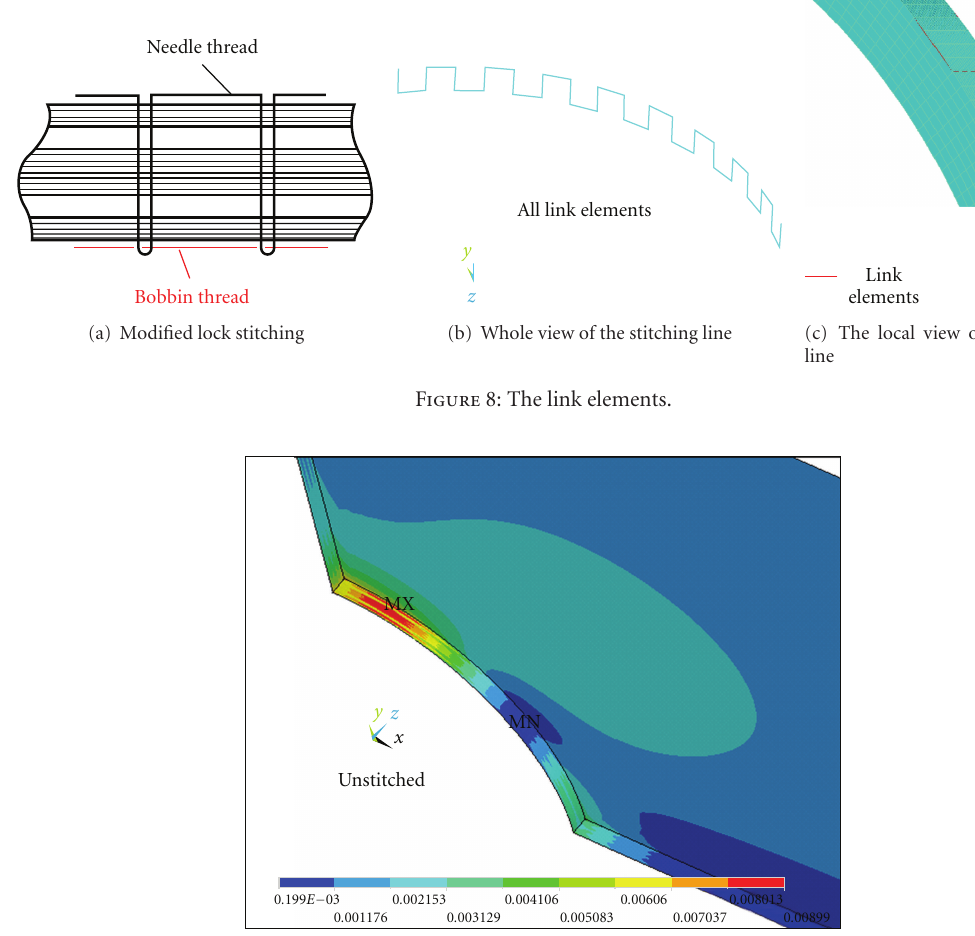
Figure 9: Mises strain distribution of the unstitching model.